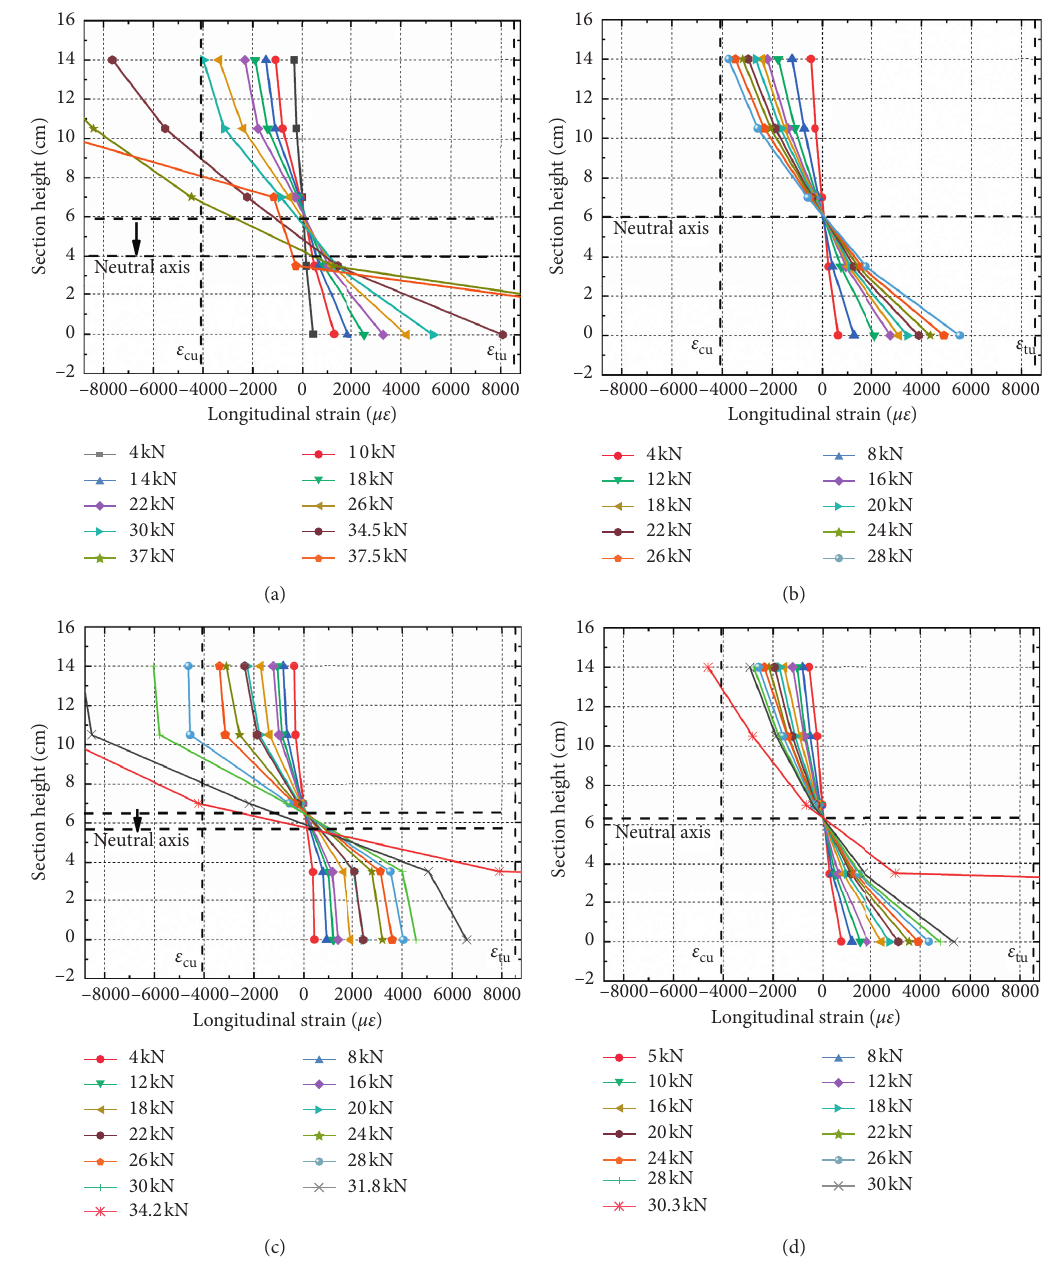
Figure 7: Section stress distributions of specimens. (a) Specimen R1/6-C. (b) Specimen R1/6-Q. (c) Specimen R1/5-C. (d) Specimen